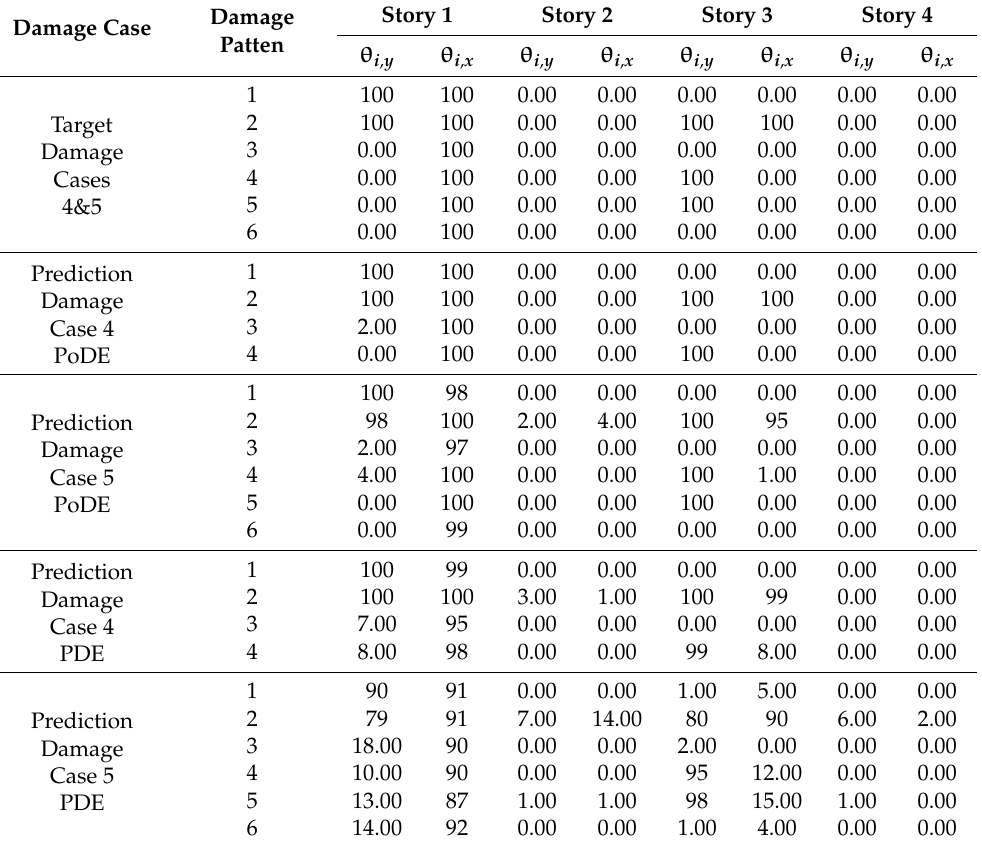
Table 3. PoDEs and PDEs for Damage Cases